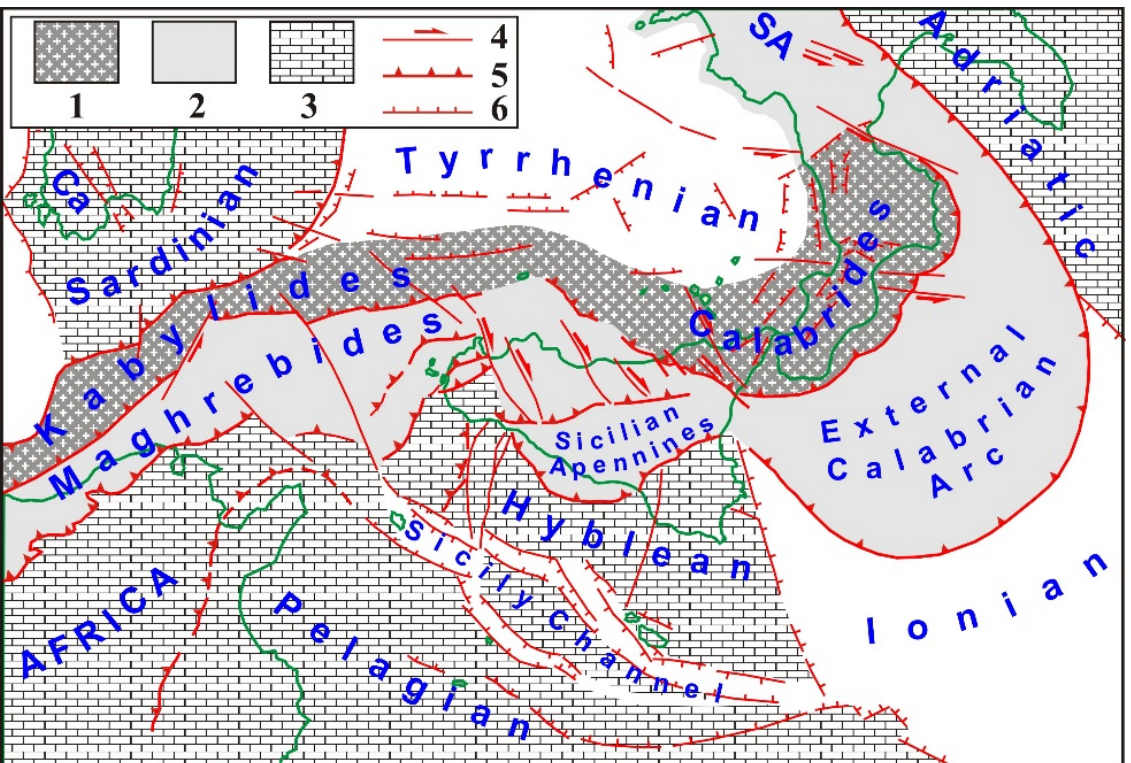
Figure 9. Shape of the Kabylides–Calabrides (1) and Maghrebides (2) belts (modified after [174,175,182]), (3) foreland domains, (4,5,6) strike-slip, compressional and tensional features. In white the basins. Ca = Campidano graben, SA = Southern Apennines.